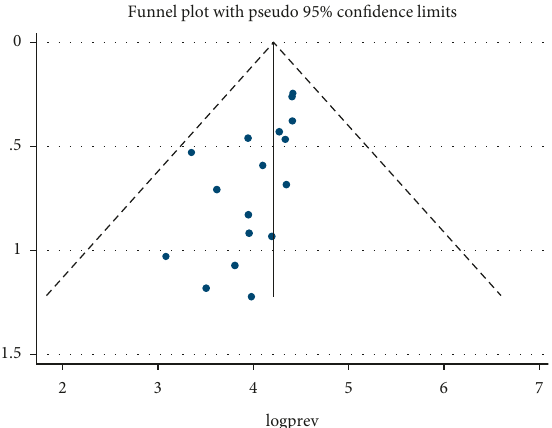
Figure 3: Funnel plot to detect the publication bias regarding prevalence of anemia,